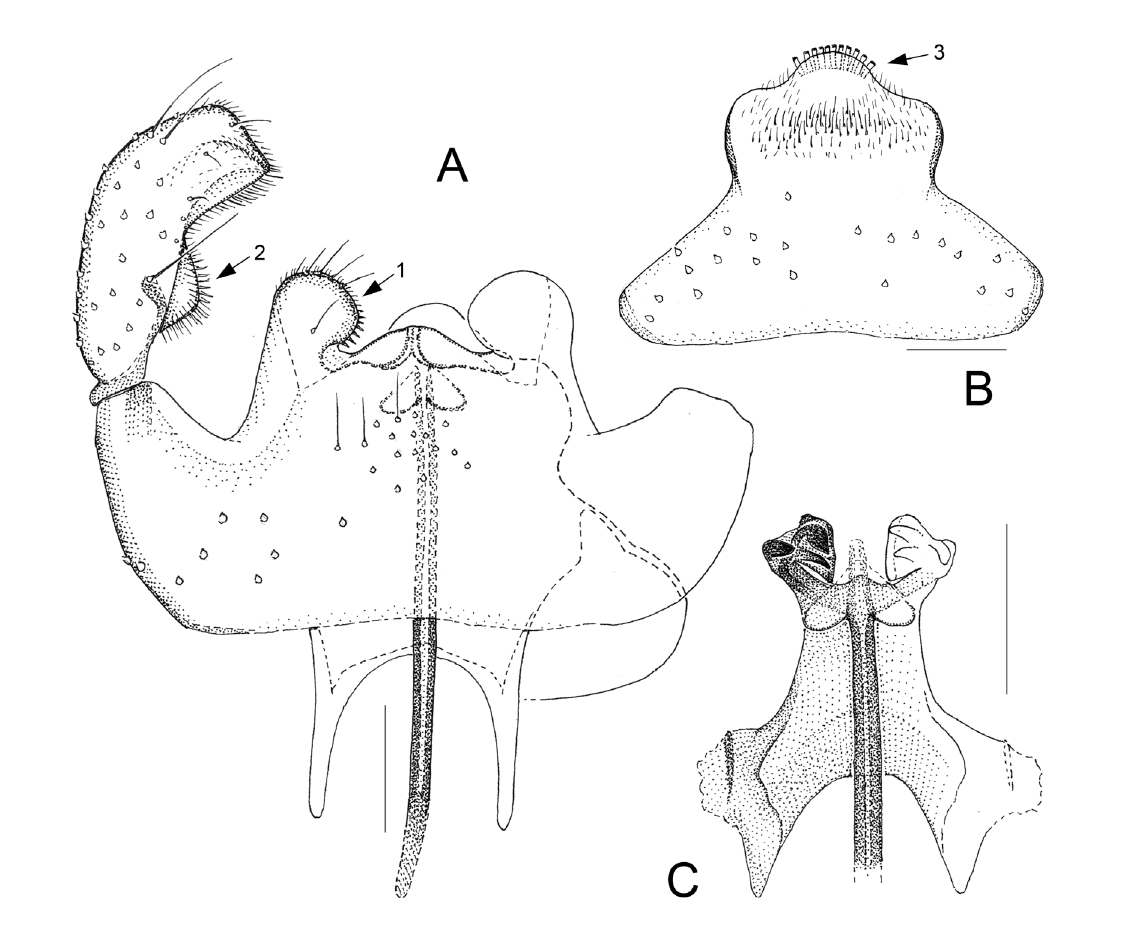
Fig. 13. Glemparon rakiura sp. nov., holotype, ♂ (NZAC, no. CEC1420). A. Genitalia, ventral. B. Ninth tergite, dorsal. C. Apex of ejaculatory apodeme and tegmen, ventral. Scale bars = 0.05 mm. Numbered arrows indicate diagnostic characters (see